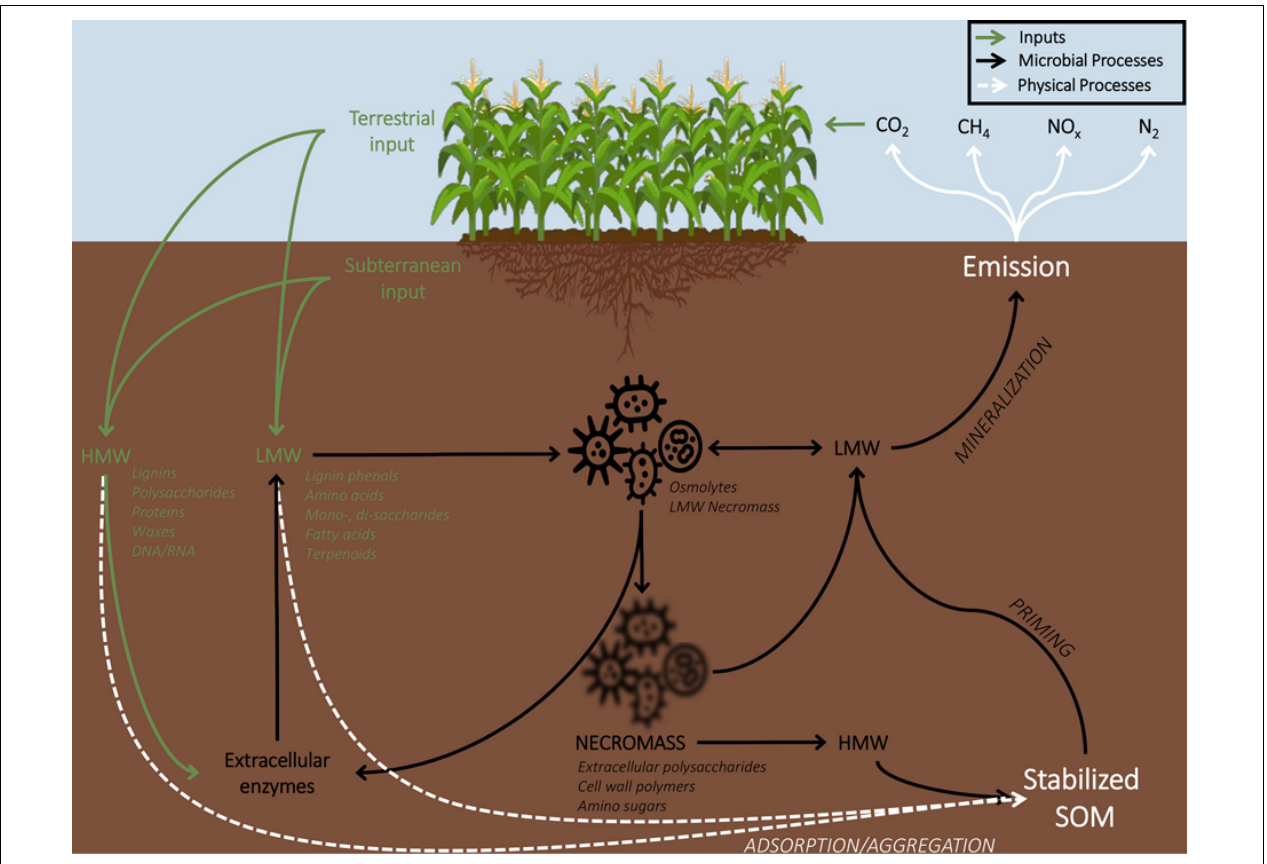
FIGURE 1 | Nutrient cycling schematic demonstrating pathways for stabilization of soil organic matter (SOM). Plant inputs in the form of litter and exudates condition the physiology of the soil microbial community. Soil microbes directly assimilate some low molecular weight (LMW) molecules and produce extracellular enzymes to degrade high molecular weight (HMW) plant inputs, undergoing respiration (and mineralization of SOM) and biomass accumulation, ultimately resulting in a net increase of stabilized C in the form of microbial